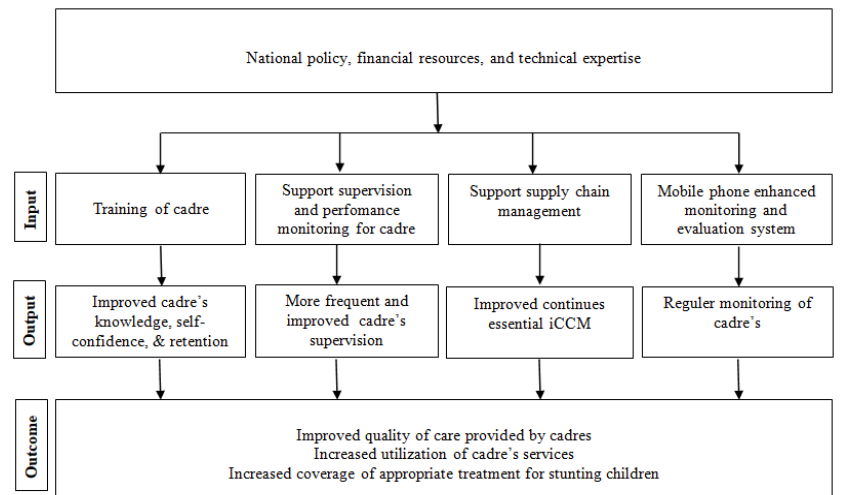
Figure 1. iCCM implementation process and conceptual framework.